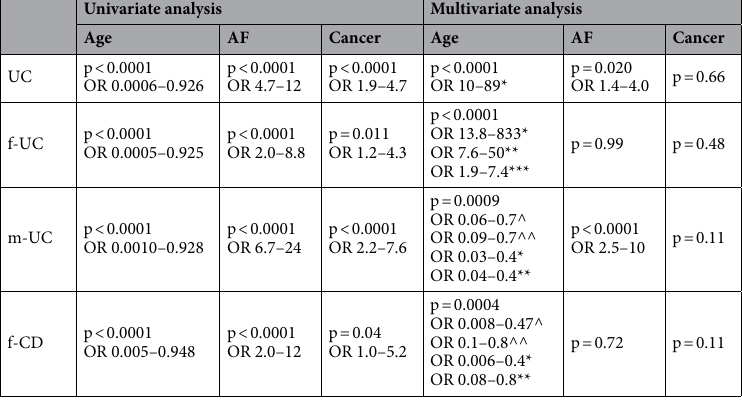
Table 2. Univariate and multivariate analyses for associations between CVAs and age, atrial fibrillation and cancer per group. *Comparing 20–40 years old to over 80 years old. **Comparing 40–60 years old to over 80 years old. ***Comparing 60–80 years old to over 80 years old. ^Comparing 20–40 years old to 60–80 years old ^^Comparing 40–60 years old to 60–80 years old, AF atrial fibrillation, UC ulcerative colitis, f-UC females with UC, m-UC males with UC, f-CD females with Crohn